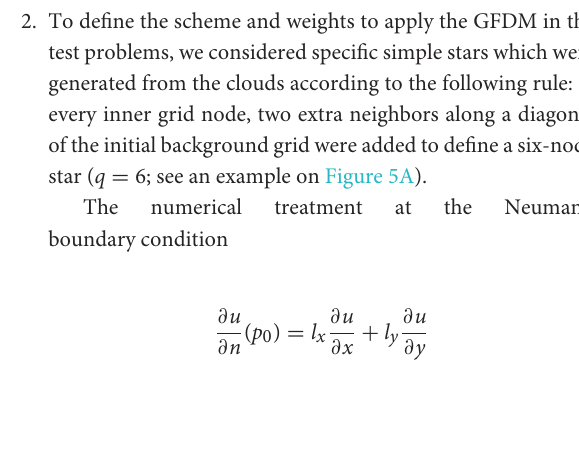
x -axis, we propose a mapping ξ 7→ x = ξ α such that